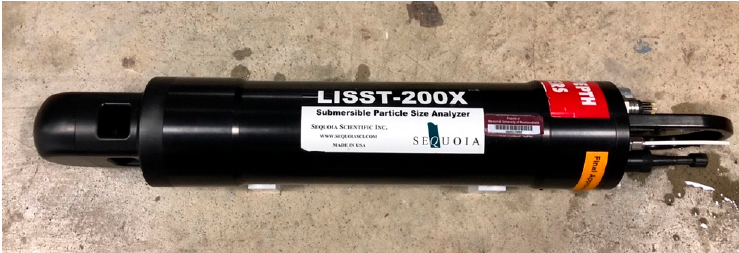
Figure 3. LISST-200X. Table 1. Specifications of Ping360